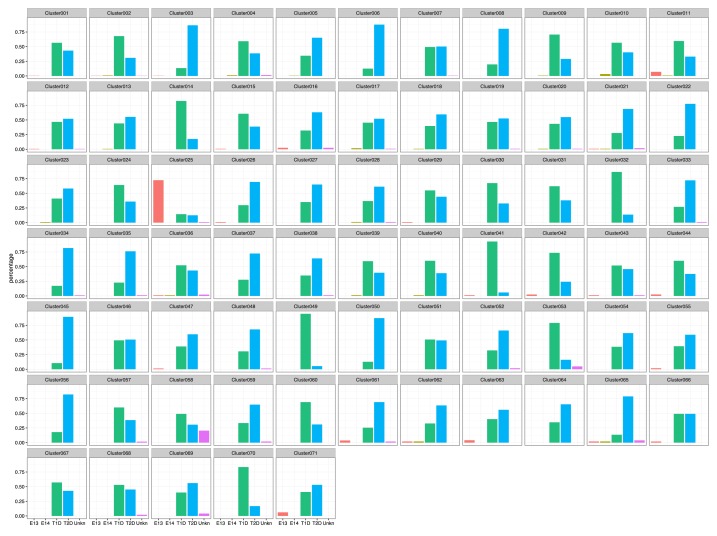
Distribution of assigned primary diabetes type for each cluster.Density diagram of days an individual has been connected to Steno Diabetes Center Copenhagen (SDCC) divided by each cluster. The black line indicates the mean of SDCC connection time for the entire cohort. Some clusters for example Cluster1, show two peaks indicating that there are at least two groups of individuals in a cluster; one connected to SDCC more than the average cohort, and one connected less.